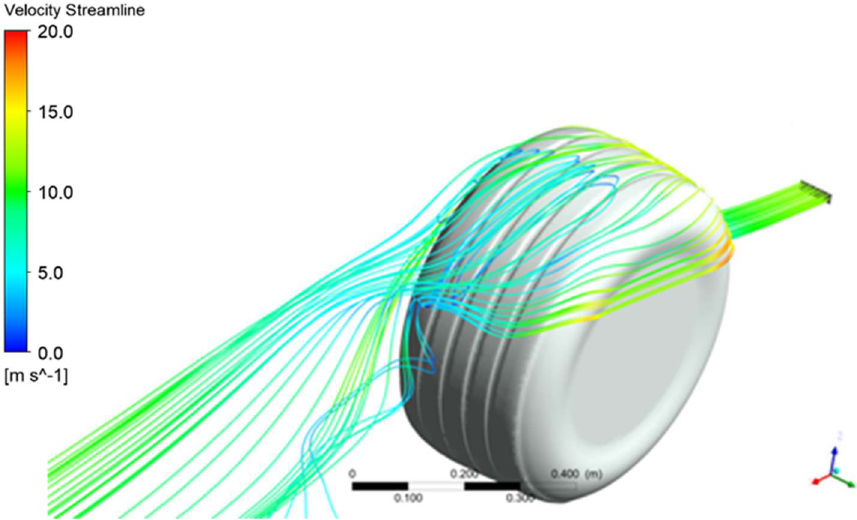
Figure 5. Streamline detail of upper vortex on the rotating wheel.